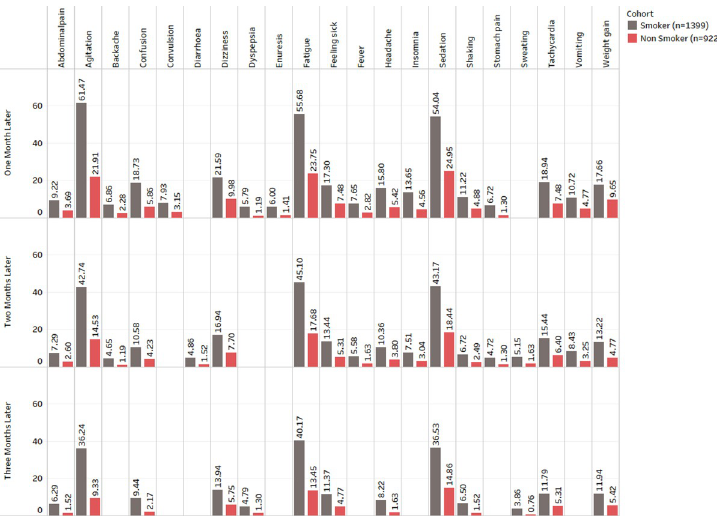
Fig 4. Frequency distribution of statistically significant ADRs (after Bonferroni p-value adjustment) from the combined analysis in smoking status for three months after starting the drug Clozapine.